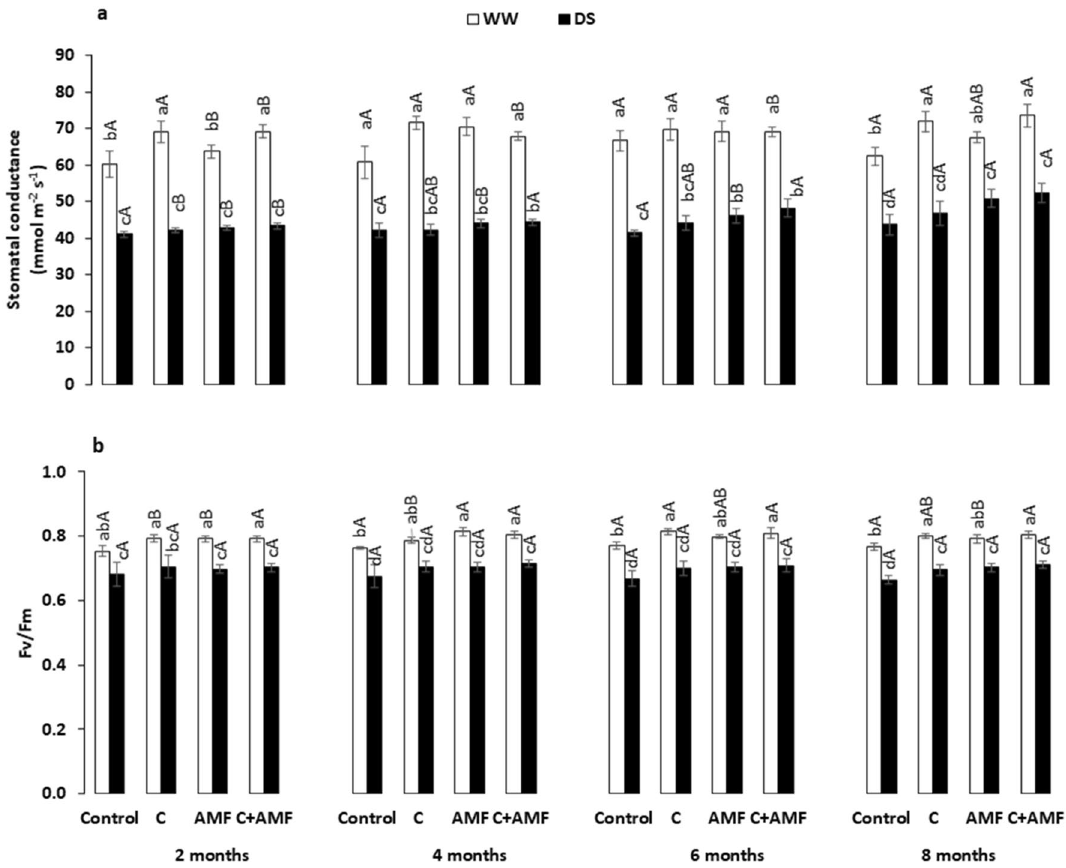
Figure 3. Influence of water regimes (WW: well-watered; open bars and DS: drought stress; filled bars) on ( a ) stomatal conductance; g s and ( b ) chlorophyll fluorescence (F v /F m ) in control carob plants and plants amended with compost (C) and/or assemblage of indigenous arbuscular mycorrhizal fungi (AMF). Data are mean ± SE (n = 5). Means followed by the same letters within the same time point are not significantly different at P < 0.05 (Tukey’s HSD). The upper case represents the differences within WW or DS water regimes, and the lower case represents the differences within a one-time